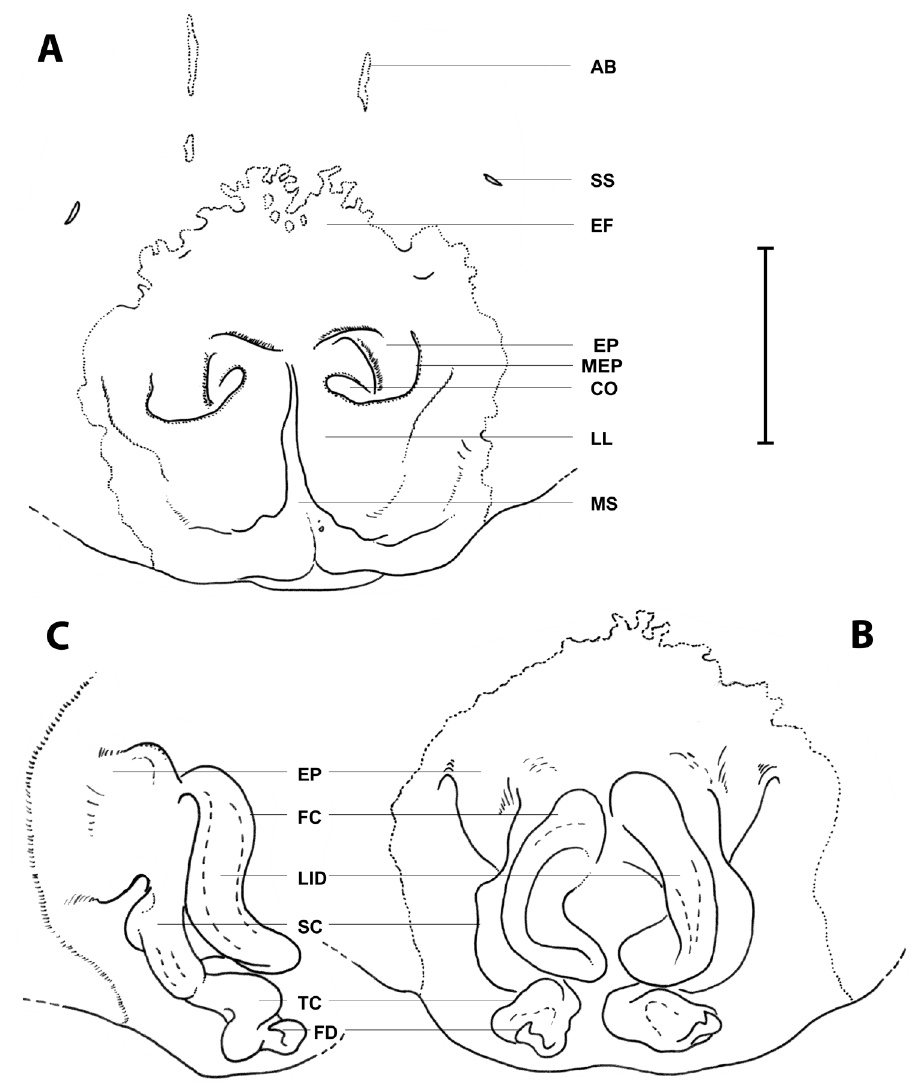
Figure 2. Spariolenus fathpouri sp. n., female paratype, Khuzestan, Pebdeh Cave, Iran (ZMUI). A epigy- num, ventral B vulva, dorsal C right vulva, lateral. Abbreviations: CO – copulatory opening; EF – epigy- nal field; EP – epigynal pit; FC – first coil of vulva; FD – fertilisation duct; LID – lumen of internal duct system; MEP – margin of epigynal pit; SC – second coil of vulva; SS – slit sensillum; TC – third coil of vulva. Scale bar: 1